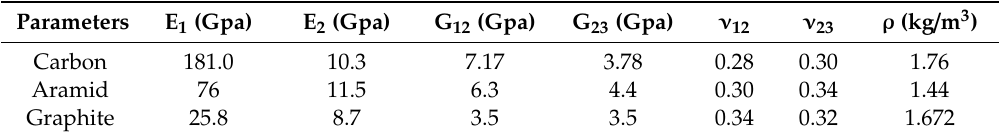
Table 2. Macroscopic mechanical parameters of composite materials.